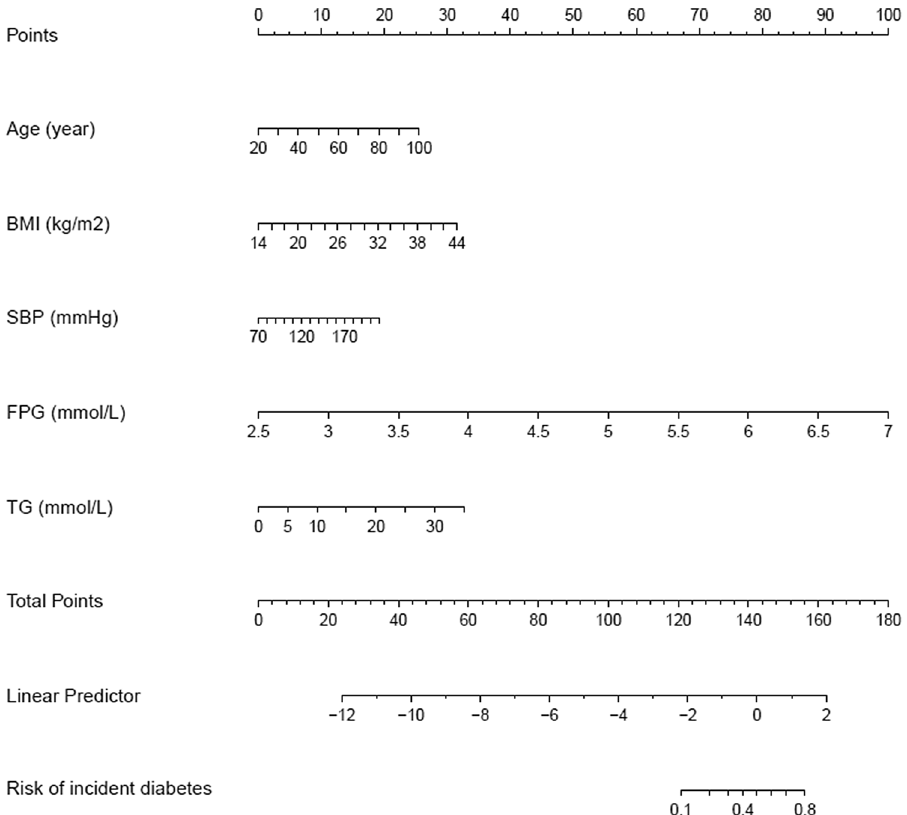
Figure 3. Nomogram to predict the risk of diabetes for Chinese adults. The patient’s score for each risk predictor is plotted on the appropriate scale and vertical lines are drawn from that value to the top Points scale to obtain the corresponding scores. All scores are summed to obtain the total points score. The total points score is plotted on the bottom Total Points scale. The corresponding value shows the predicted probability of incident